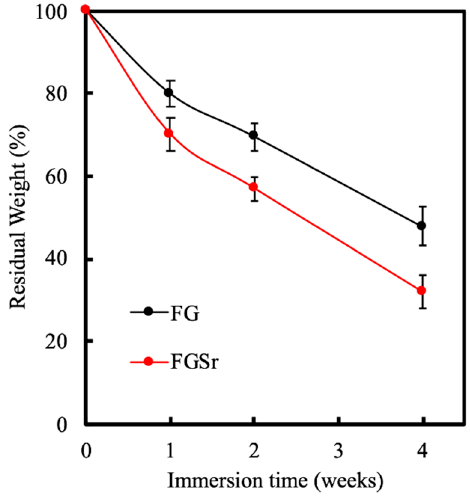
ff olds immersed in SBF for di ff erent Figure 6. The weight loss of FG and FGSr scaffolds immersed in SBF for different time-points. Figure 6. The weight loss of FG and FGSr sca